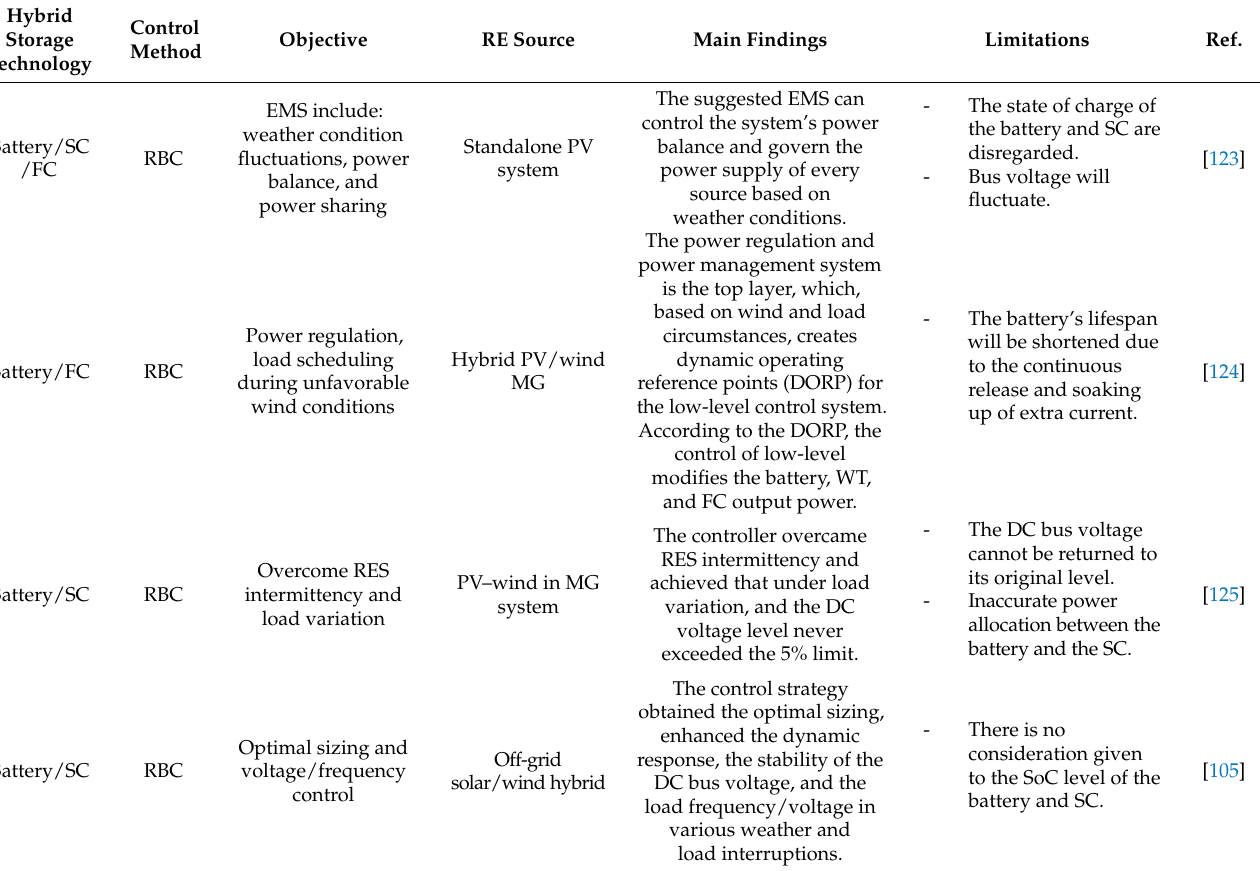
Table 4. The review analysis of the common conventional control methods for HESS integrated RE